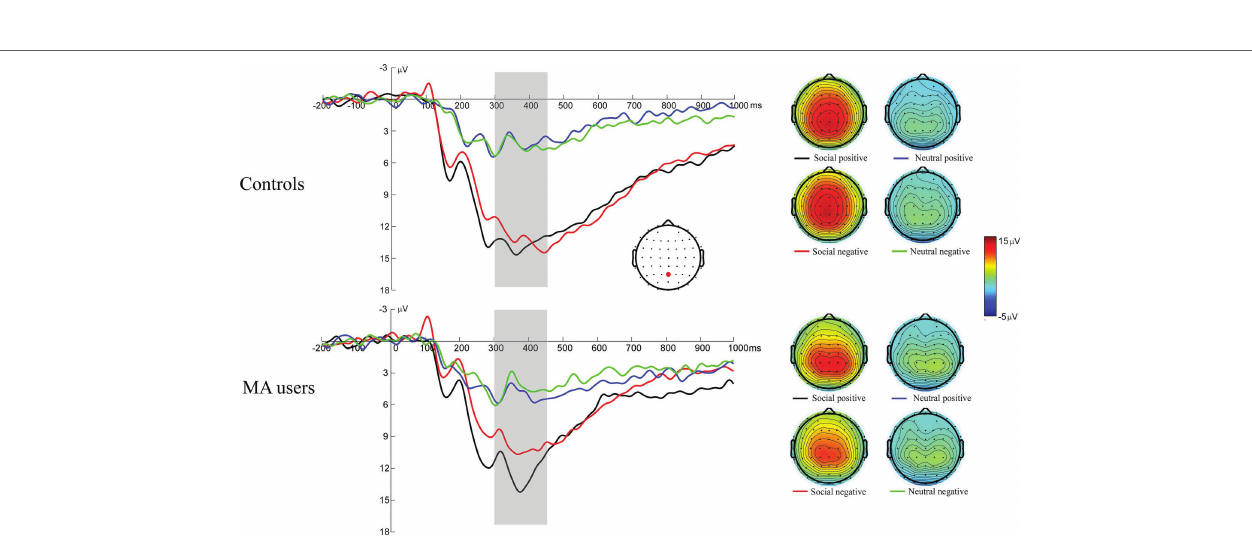
FIGURE 4 | Left: FB-P3 responses to social positive and negative feedback on SID. Feedback onset was at 0 ms. Fb-P3 was scored as the averaged activity from 300 to 450 ms following feedback onset. Right: The scalp distributions of the ERP responses to positive and negative feedback on